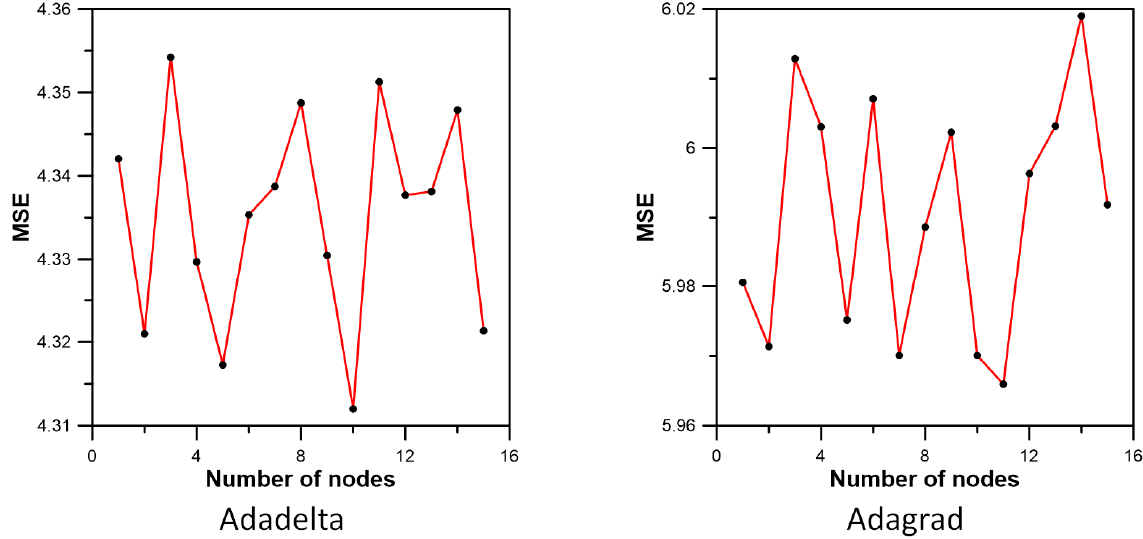
Figure 11. Results according to the number of nodes (Adadelta and Adagrad). When Adadelta was applied in MLP, the best results were obtained there were 10 nodes. When Adagrad was applied in MLP, the best results were obtained there were 11 nodes. Figure 12 shows the results according to the number of nodes (Adam and Adamax).